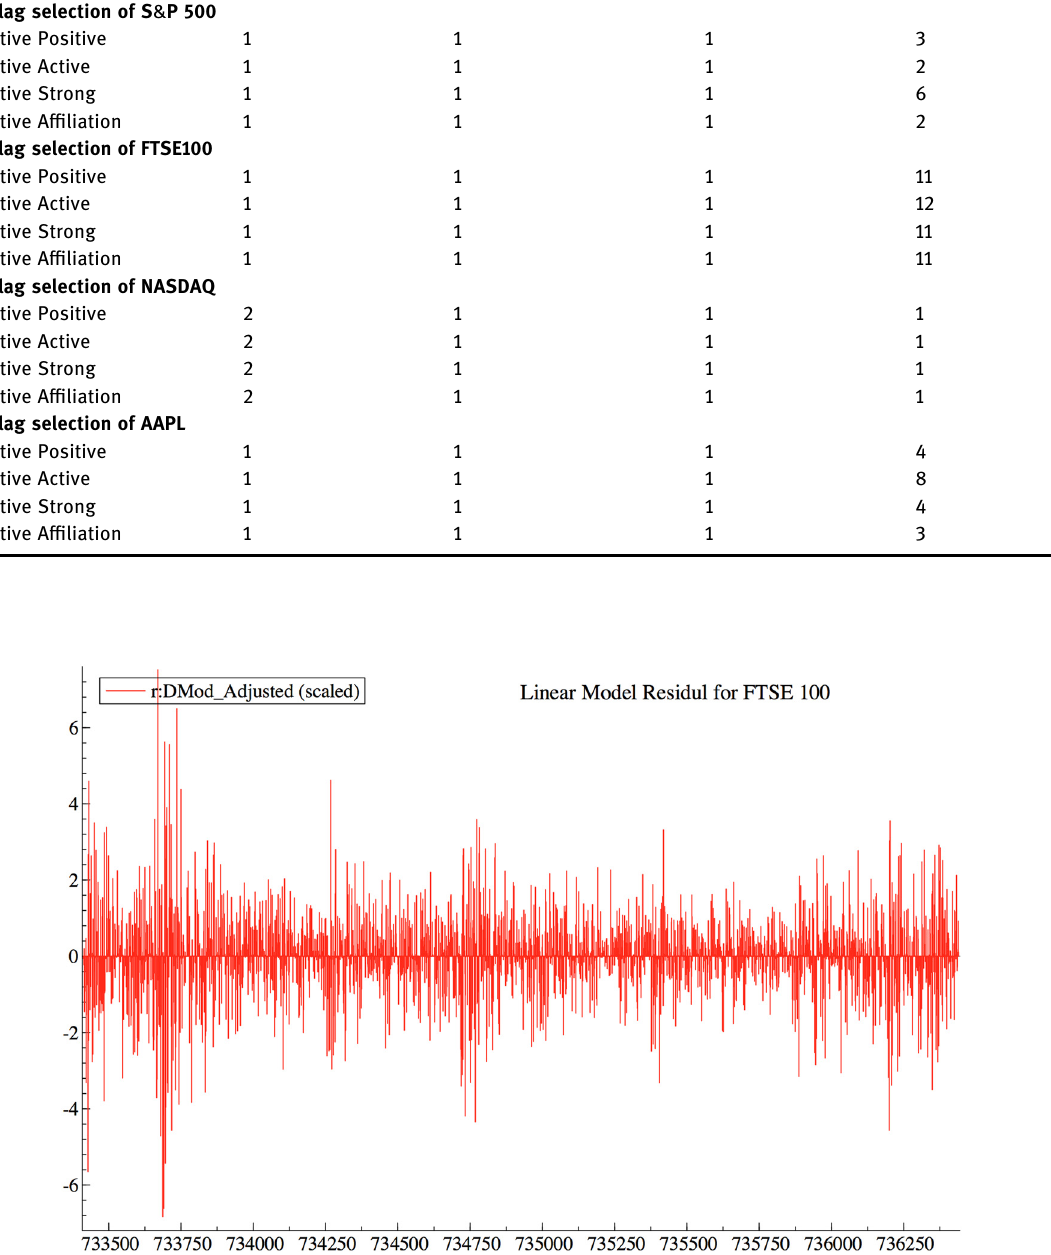
Figure A1: Residuals from the ADL linear predictive model for FTSE 100